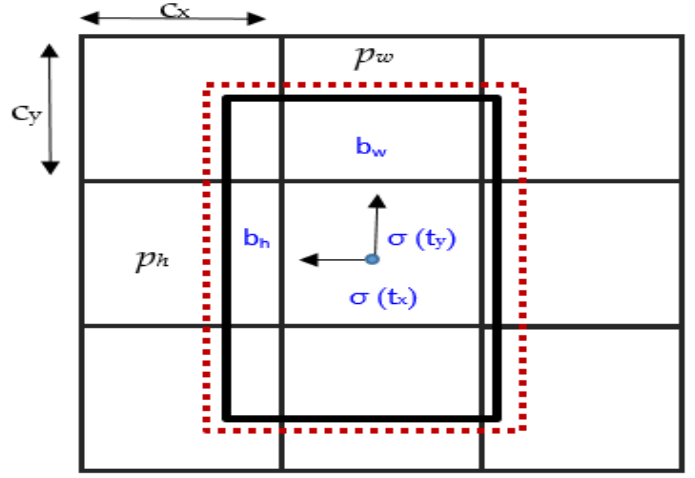
Figure 3. The bounding box highlighting positions of the values for further classification.